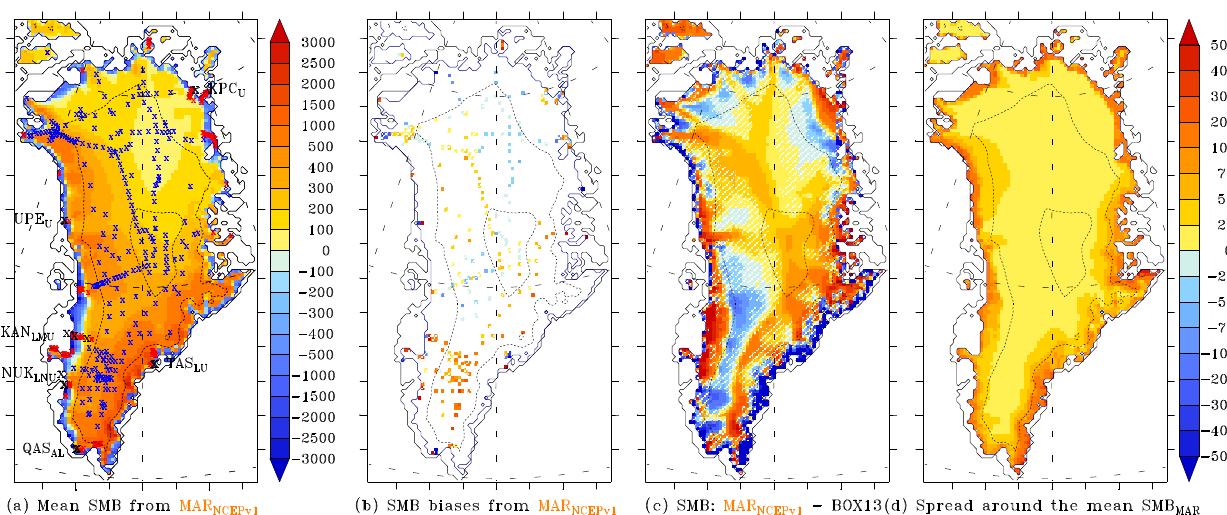
Figure 6. (a) Mean annual SMB (in mm.w.e.yr − 1 ) simulated by MAR forced by NCEPv1 over 1958–2010. The ice core locations from Bales et al. (2001, 2009) and Ohmura et al. (1999) used to validate MAR are quoted in blue, while the MACHGUTH16 SMB sites (Machguth et al., 2016) are in red. (b) Mean biases (in mm.w.e.yr − 1 ) of MAR forced by NCEPv1 over 1958–2010 with respect to both ice core and MACHGUTH16-based SMB estimations. The biases lower than the interannual variability of MARv3.5.2 forced by NCEPv1 over 1958– 2010 are hatched. (c) Comparison over 1958–2010 between the mean SMB (in mm.w.e.yr − 1 ) simulated by MAR and from the BOX13 reconstruction. Again, the biases lower than the interannual variability of MARv3.5.2 forced by NCEPv1 over 1958–2010 are hatched. (d) Spread (i.e. standard deviation in mm.w.e.yr − 1 ) around 6 estimations of the mean 1958–2010 SMB as simulated by MAR forced